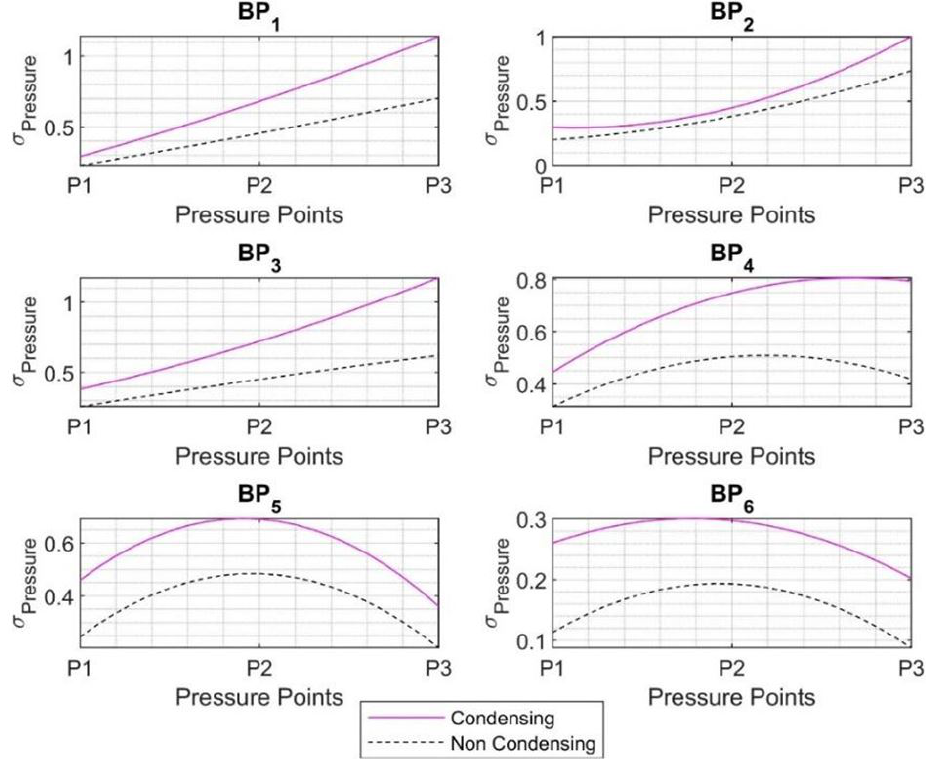
Figure 9. Deviation from the mean